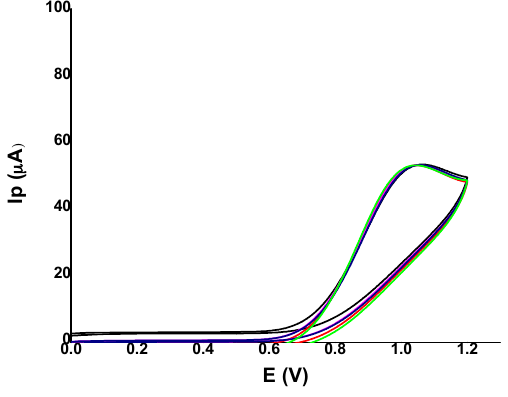
Figure 7. Five repetitive CVs for Px-CuO NS-modified GCE in 0.5 mM nitrite in phosphate buffer (pH, 7.0) using scan rate of 100 mV s − 1